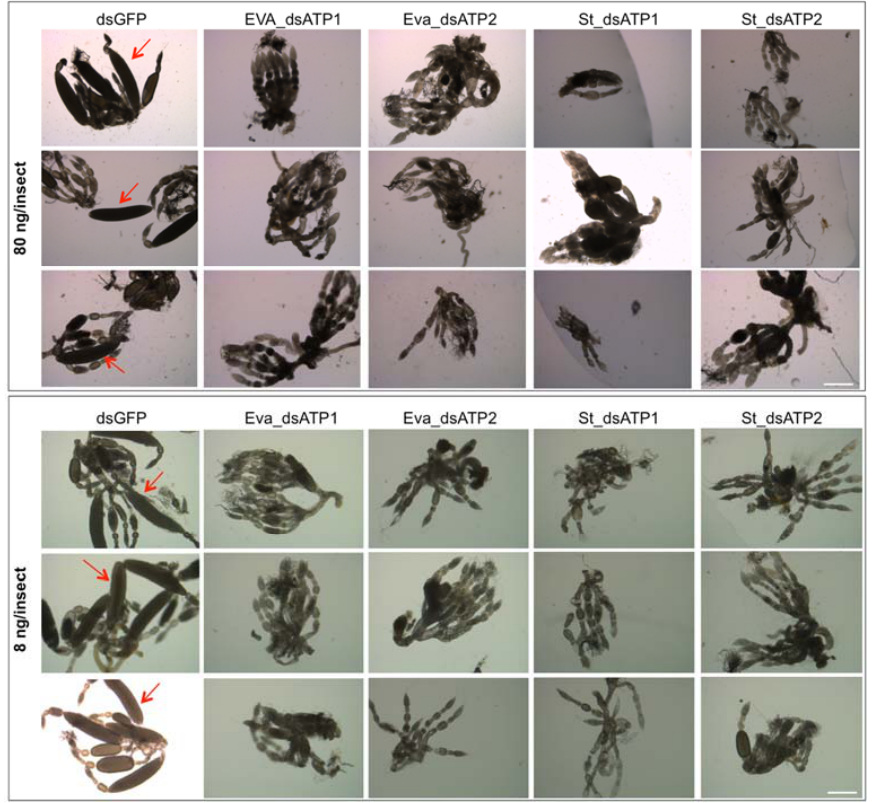
Figure 7. Effects on Euscelidius variegatus ovaries following silencing of ATP synthase β . Images of the ovaries of E. variegatus adults collected at 15 days post injection with 80 (upper panels) and 8 (lower panels) ng/insect of dsRNAs targeting green fluorescent protein (dsGFP), used as the control, or ATP synthase β of E. variegatus (Eva_dsATP1, Eva_dsATP2) and of Scaphoideus titanus (St_dsATP1 and St_dsATP2) observed in bright field. Red arrows indicate mature eggs in dsGFP panels. For each treatment and dose, organs from three individuals were observed. Bars = 500 μ m. Table 3. Effects of ATP synthase β silencing on Euscelidius variegatus progeny. Numbers of offspring of E. variegatus following the injection of newly emerged F0 parent adults with different doses of dsRNAs targeting green fluorescent protein (GFP) or different portions of ATP synthase β gene of E. variegatus (Eva_dsATP1, Eva_dsATP2) and of Scaphoideus titanus (St_dsATP1, St_dsATP2). Groups of injected F0 females and males listed in the same line were caged together for 15 days right after the dsRNA injection. Numbers of males and females collected alive at the end of this period are indicated. Offspring insects (F1, nymphs, and adults) were collected 60 days post injection. dsRNA Injected